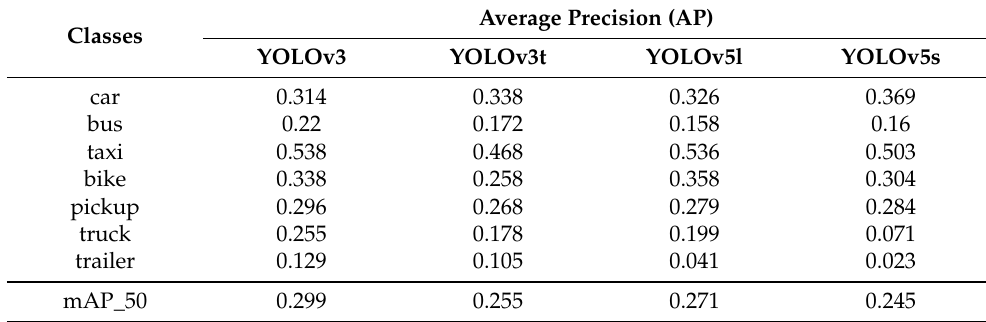
Table 3. Performance of the YOLO networks trained on TR1 evaluated on TR2 as test data before fine-tuning.